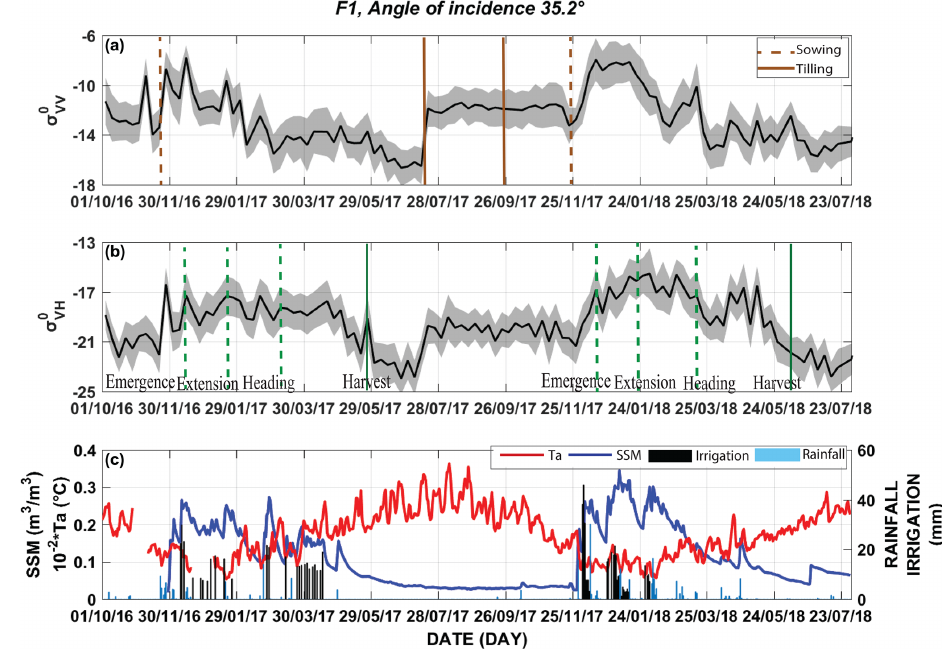
Figure A3. Time series of the backscattering coefficient at VV (a) and VH (b) polarizations on F1 at a 35.2 ◦ incidence angle during the period from 1 October 2016 to 31 July 2018. The tilling works and phenological stages of wheat are superimposed in panels (a) and (b) , respectively. The air temperature, surface soil moisture (SSM), irrigation and rainfall are displayed in panel (c) .